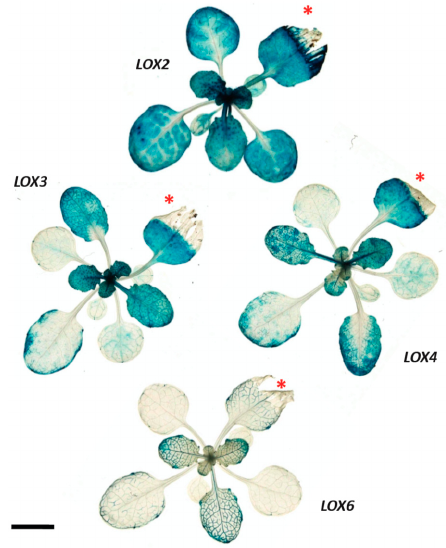
Figure A1. Expression of LOX promoter::GUS reporters in wounded rosettes. Plants were wounded on a single leaf (orange asterisk) and harvested 6 h later prior to staining for GUS activity. Scale bar = 1 cm.